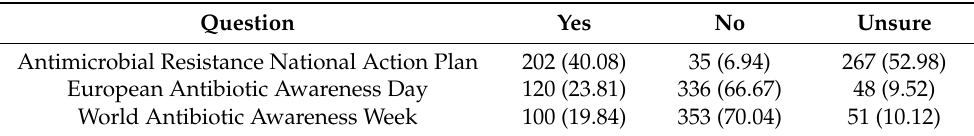
Table 7. Respondents who were aware/unaware of whether their country had a national action plan on antimicrobial resistance, who had/had not heard of European Antibiotic Awareness Day, and who had/had not heard of World Antibiotic Awareness Week ( n = 504). Question Yes No Unsure Antimicrobial Resistance National Action Plan